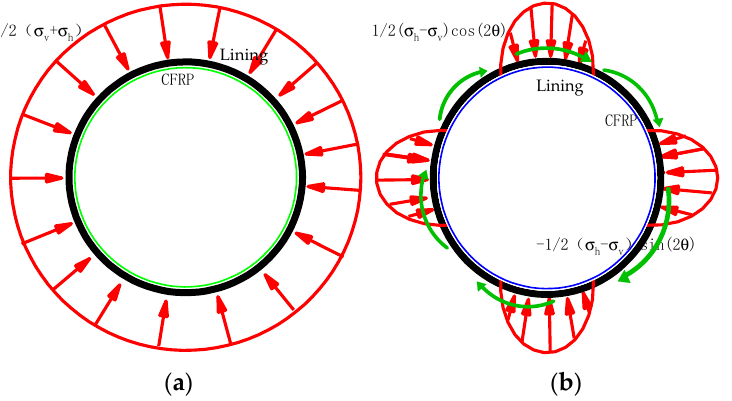
Figure 2. External surface load on lining reinforcement of CFRP. ( a ) Confining pressure action diagram ( b ) Compression–shear combination action diagram with trigonometric functions.